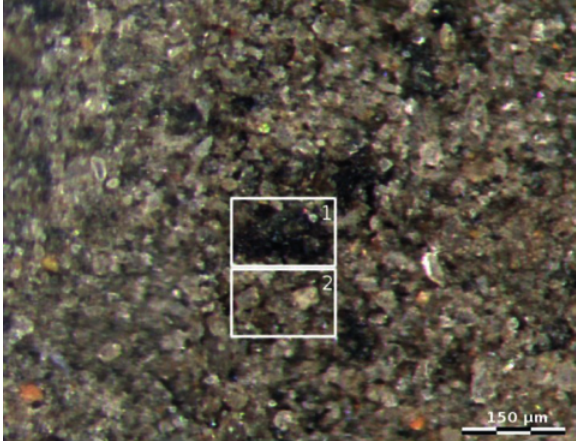
Fig. 3. SEM image of snow meltwater filter sediments: (a) sampling distance 1 m; (b) sampling distance 20 m. Carbon is mapped in red, Ca is mapped in blue colour. Ca may be geogenic (from loess) or anthropogenic (from de-icing